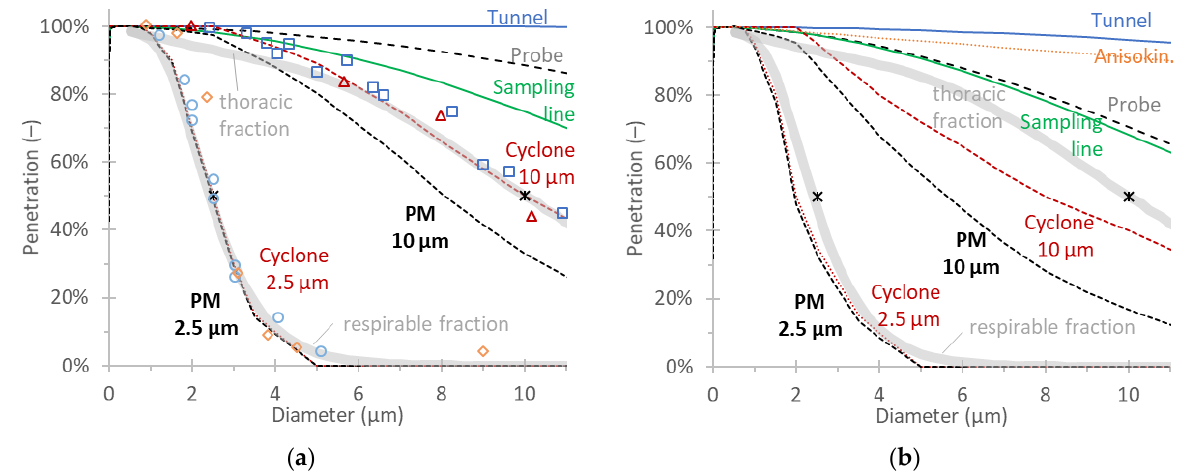
Figure 3. Monodisperse particle penetration of the PM setup with 2.5 µm and 10 µm cyclonic separators assuming: ( a ) minimum losses (“max penetration” setup); ( b ) maximum losses and flexibilities (“min penetration” setup). Asterisks indicate 50% penetration at 2.5 µm and 10 µm. Open symbols are penetrations from the calibration certificates of cyclonic separators.